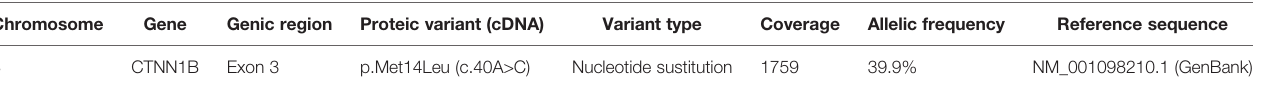
TABLE 1 | Genic variant detected by